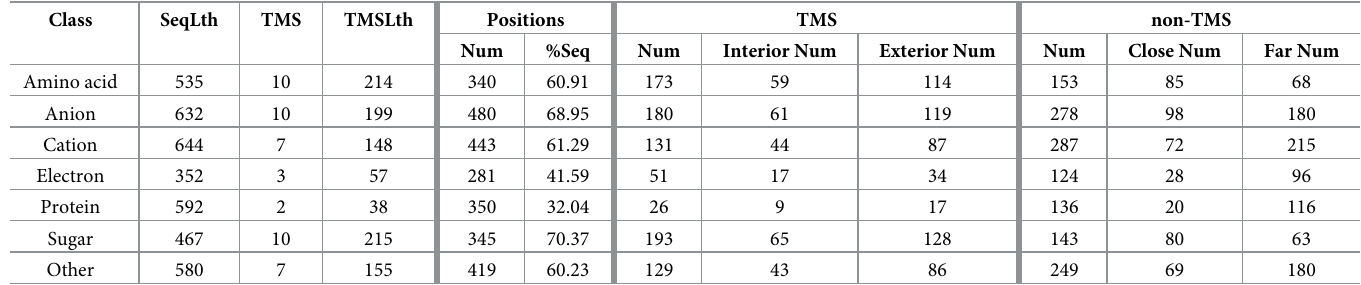
Table 7. Positional information.